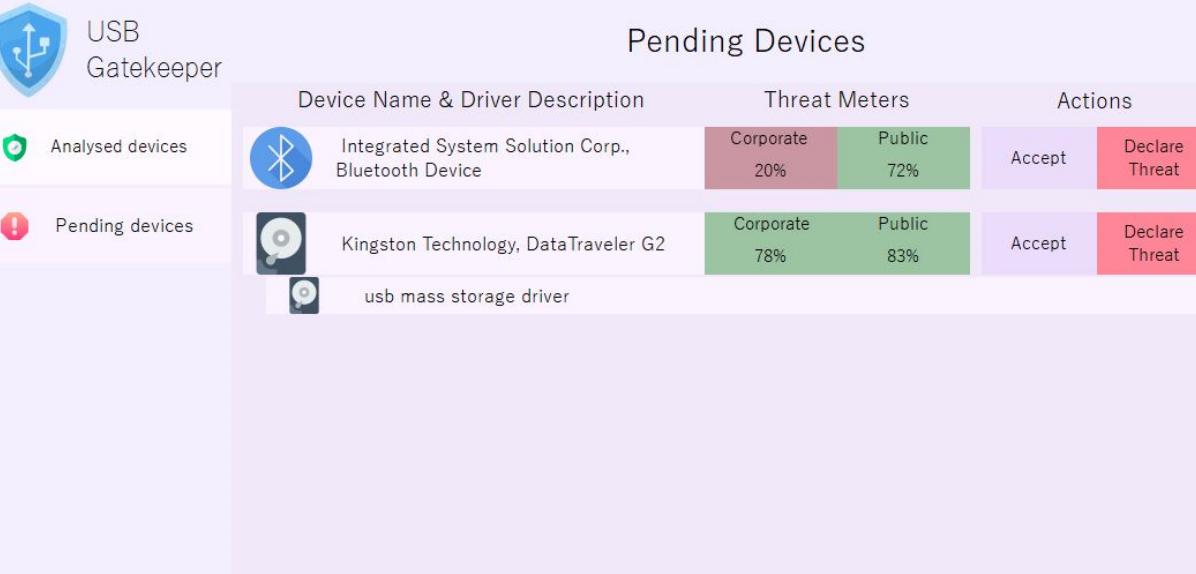
Figure 5. List of pending